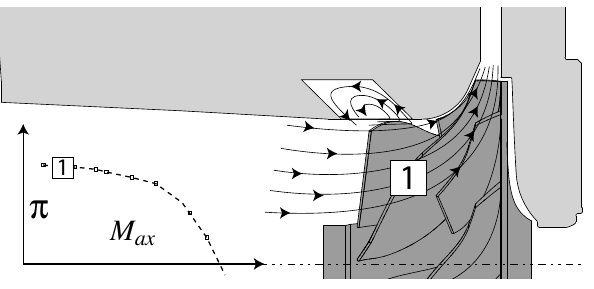
Figure 4. Schematic of the developed CT including flow recirculation for highly throttled operation.